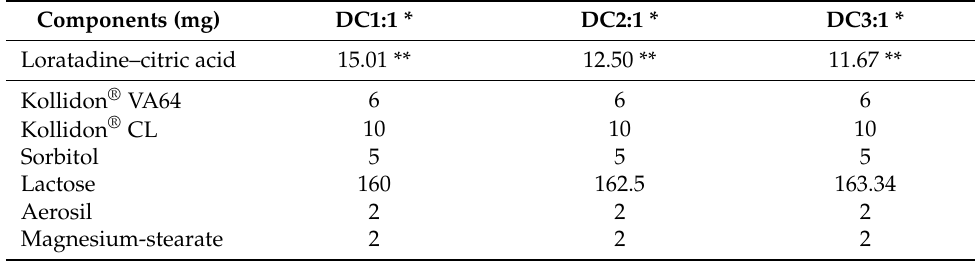
Table 1. ODx composition prepared by direct compression. Components (mg) DC1:1 * DC2:1 * DC3:1 * Loratadine–citric